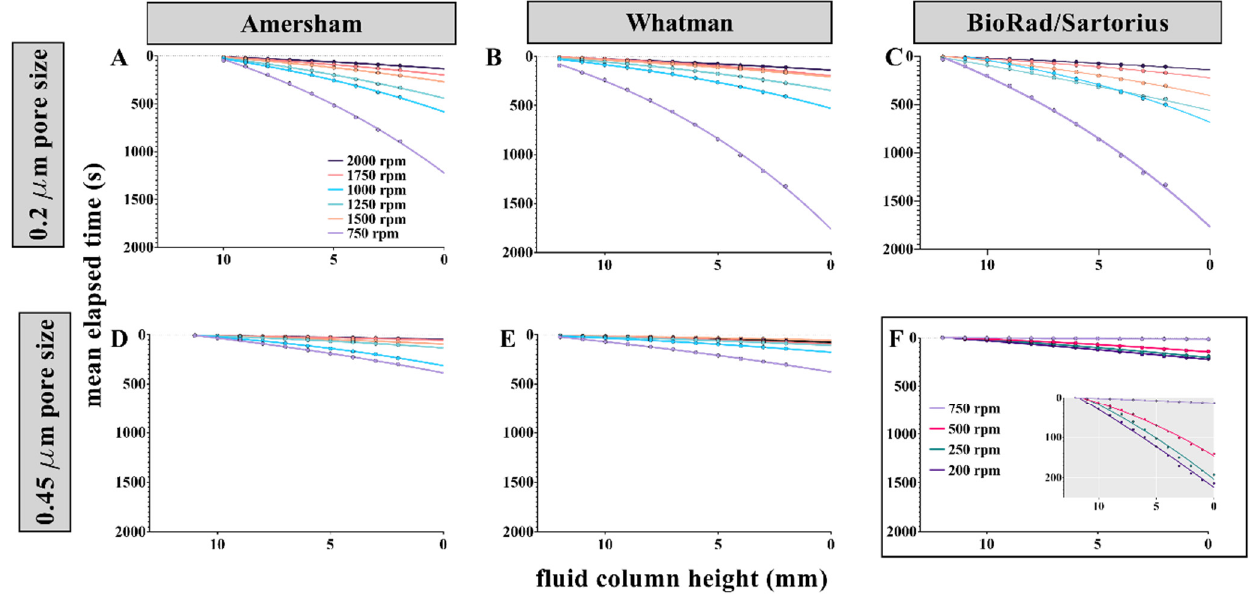
Figure 3. Exponential decay curves depicting the remaining fluid column height in the sample chamber ( ∆ r ) as a function of elapsed time. Assay buffer (200 µ L) was loaded into each sample chamber (Figure 1 inset). Rotational frequency (rpm) was held constant for each fluid drainage trial (n = 4 for each membrane type-rpm pairing). A high-speed, stroboscopic video system was used to visualize incremental changes in the height of the fluid column over time. Plots ( A – F ) depict mean elapsed time (s) vs. the remaining fluid column height in the sample chamber (mm). Colored points represent mean elapsed time for individual trials at each rotational frequency. Solid colored lines represent exponential best fit curves for mean elapsed time values. The top row, plots ( A – C ), reflect flow profiles for NC membranes with 0.2 μ m pore size. Plots ( D , E ) (bottom row) reflect drainage profiles for NC membranes with 0.45 μ m pore size. Pore size for the Sartorius Unisart membrane was unknown. Note: Rotational frequencies for Sartorius Unisart membranes (panel ( F ) and ( F )-inset) were much lower than other membranes ( A – E ).